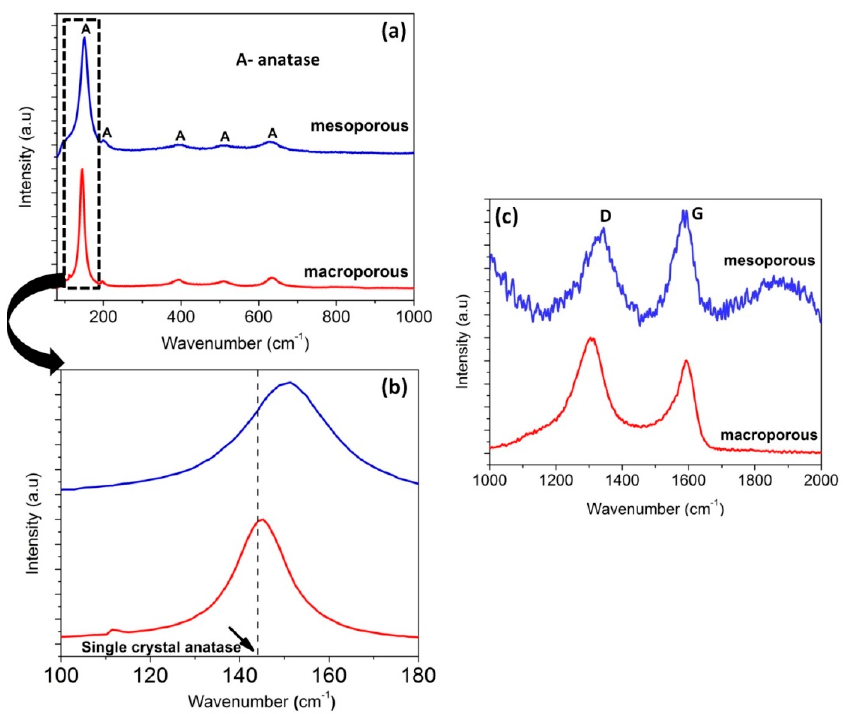
Figure 4. Raman spectra ( a ) of the samples revealing the anatase phase of TiO 2 in macroporous